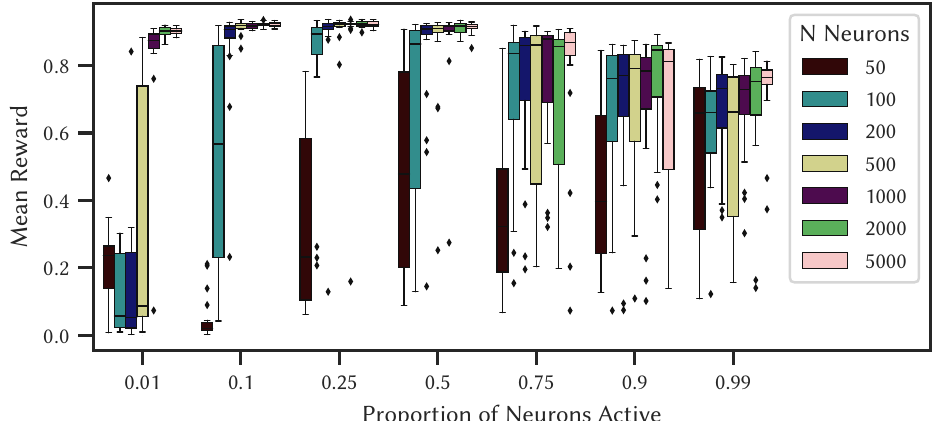
Figure 11. Mean reward gained over 200 learning trials for each configuration of the Actor-Critic network exploring how sparsity (proportion of neurons active at any given time) and number of neurons impacts network performance on a spatial reinforcement learning task